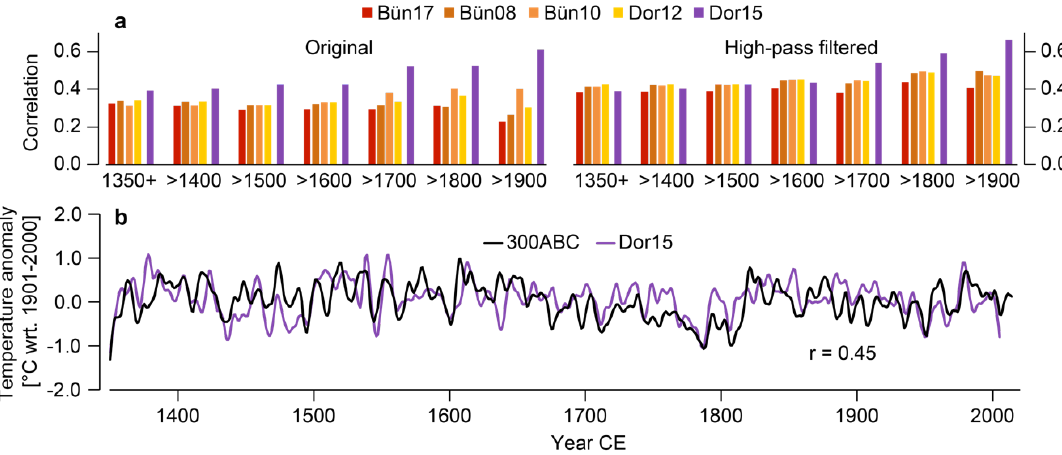
Figure 10. Comparison with existing reconstructions. ( a ) Pearson correlations of the ABC300 temperature reconstruction with warm season temperature reconstructions from the Pyrenees (Bün08, Bün10, Bün17, Dor12) and a previous-year late summer temperature reconstruction from CNP tree-ring width (TRW) data (Dor15). The Dor15 record has been reversed and shifted by one year (see Methods). The left panel shows the results for the original reconstructions, right panel after 10-year high-pass filtering the timeseries. ( b ) The 10-year smoothed ABC300 reconstruction plotted together with the (reversed) Dor15 reconstruction since 1350 CE.